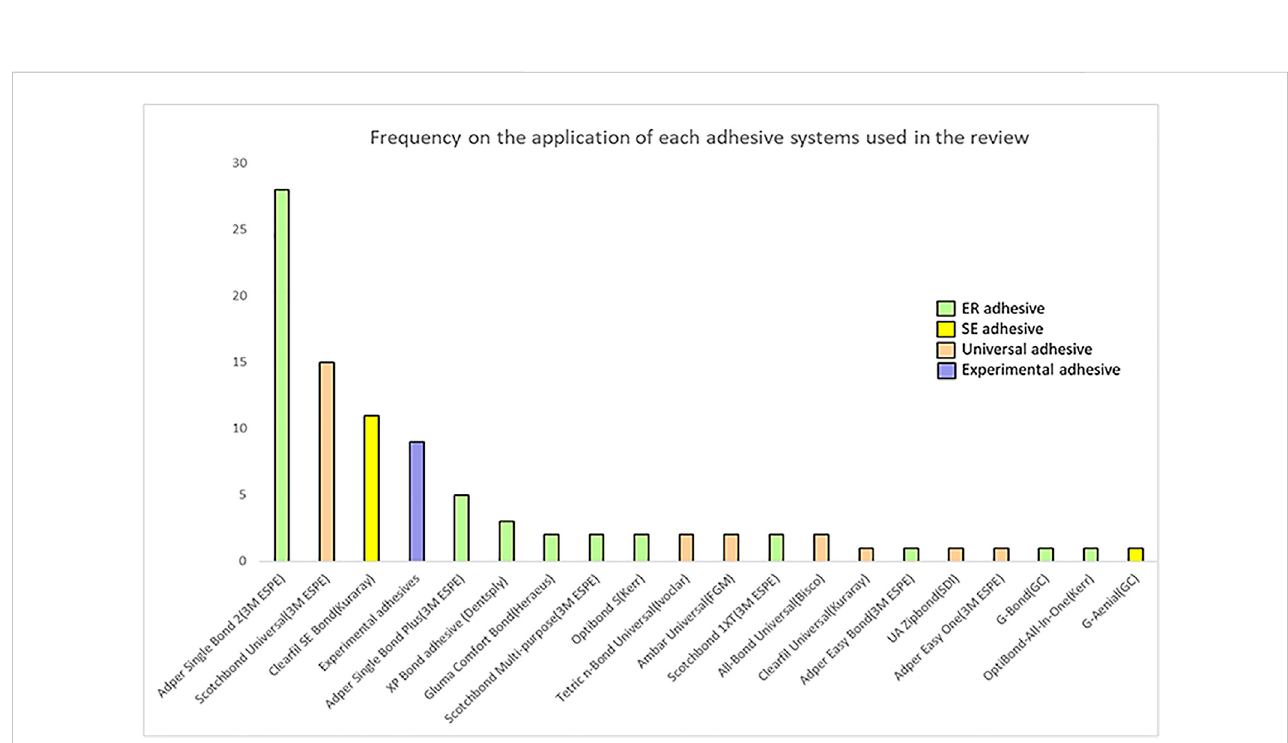
FIGURE 2 Frequency on the application of each adhesive systems used in the